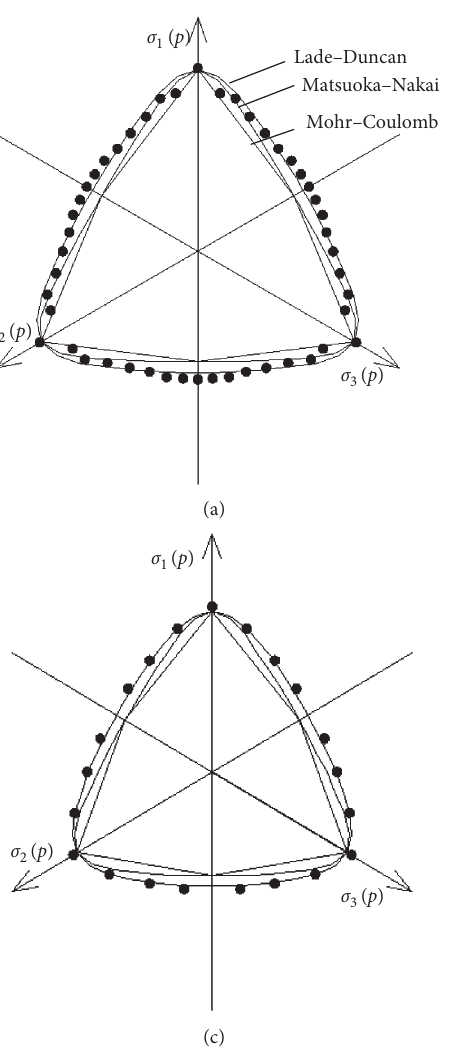
Figure 16: The failure states in the π plane and the envelopes of strength criteria: (a) σ (d) Lade–Duncan envelopes under different confining